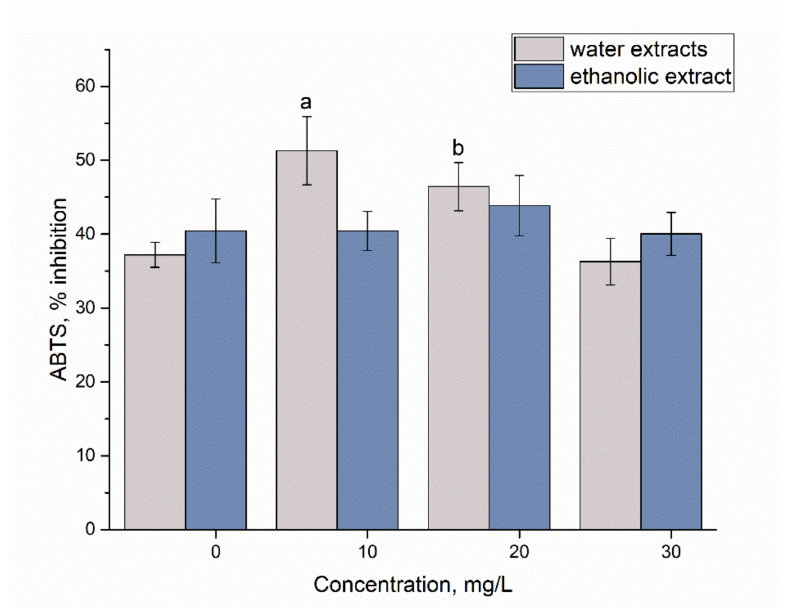
Figure 8. The antioxidant activity of extracts obtained from A. platensis biomass exposed to Eu(III) in concentrations 10–30 mg/L (a— p < 0.01, b— p < 0.05for the difference between sample and